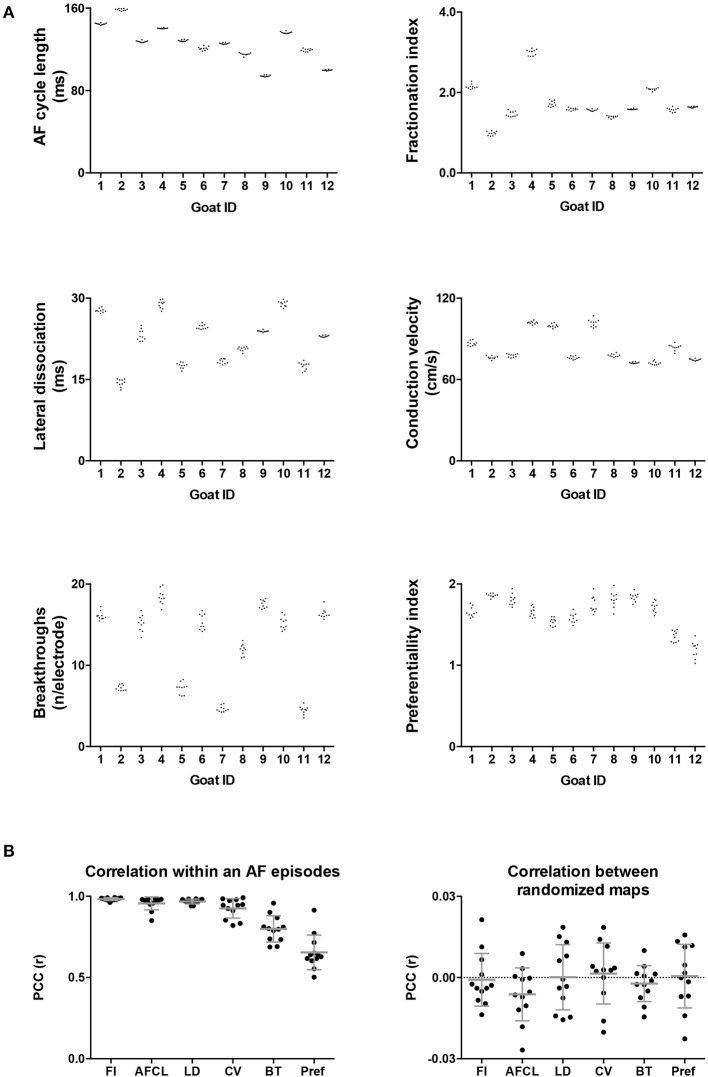
(A) Intra-episode PCC for 6 different AF parameters. On the x-axis the individual animals are given. Panel A represents the absolute average of a map in a 60-s-recording. Per animal 10 values of the 10 consecutive maps are given. (B) In the first panel the average PCC, based on 45 correlations, is given per animal per parameter. The right-hand panel confirms that this high degree of stationarity did not occur due to chance since breaking the spatial coherence completely removed the correlation.